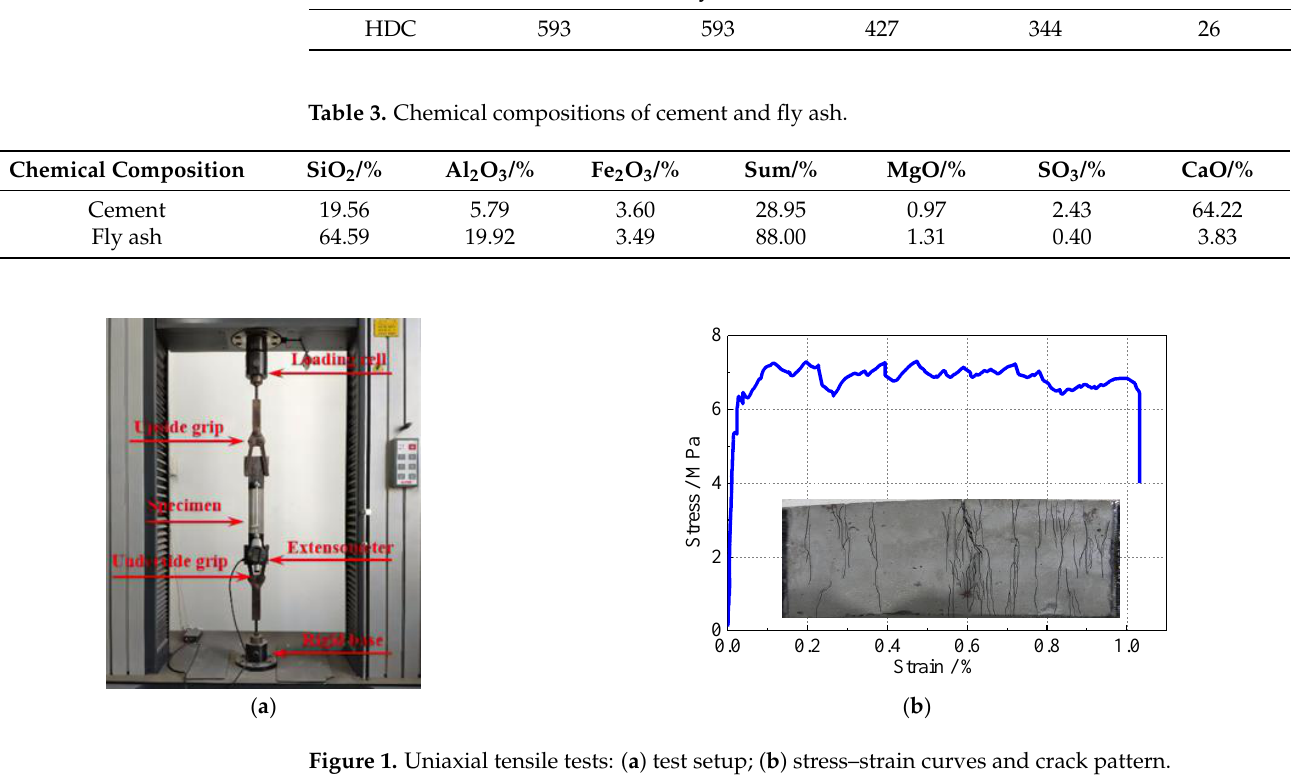
Table 2. Mixture proportions of HDC (kg/m 3 ).